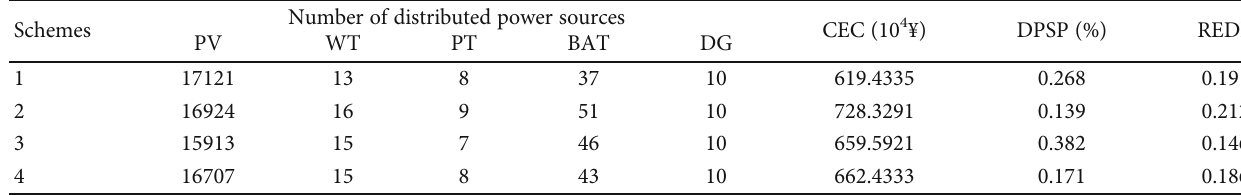
Table 4: Distributed power supply con fi guration results of MOGWO.